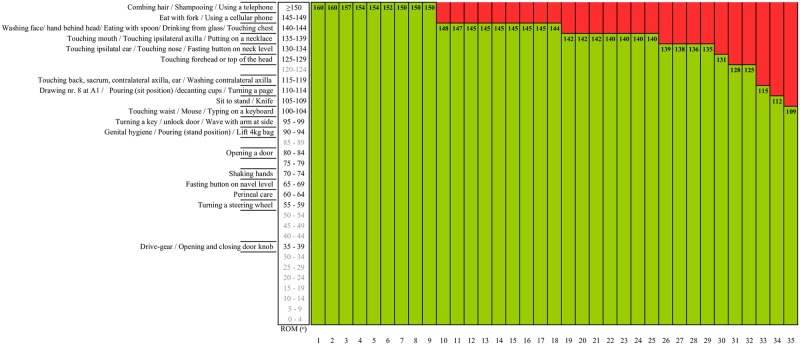
Schematic illustration of activities of daily life (ADL) that can (green) or cannot (red) be performed after burn injury in the elbow joint area, based on measured Range of Motion (ROM) of 35 elbows 3 month post burn (ROM given in bold numbers) and the required elbow flexion ROM for 44 different ADL tasks as synthesized by Oosterwijk et al. [29–30].Note that many of these ADL tasks need almost full elbow flexion so that even a small ROM deficit can have considerable impact on daily functioning.